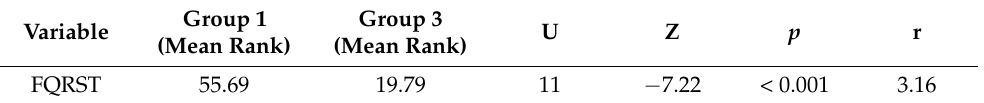
Table 4. Comparison of recorded parameters (Mann Whitney test) between group 1 ( n = 35, with low PAL) and group 3 ( n = 38, with high PAL), grouping variable IPAQ category. Variable